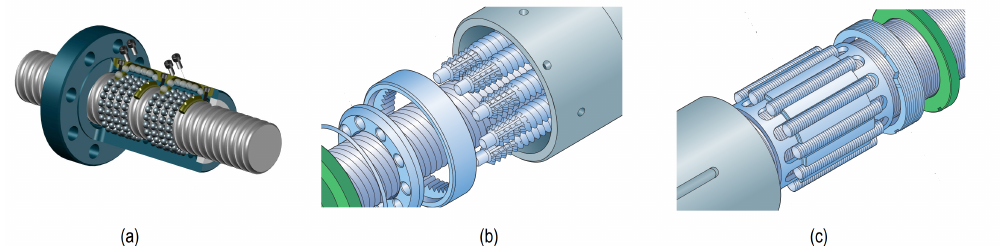
Figure 17. Screw mechanisms: ( a ) ball screws, reproduced with kind permission from Barness Industries Ltd. [107], ( b ) planetary roller screws ( c ) recirculating roller screws, reprinted with kind permission from SKF Group